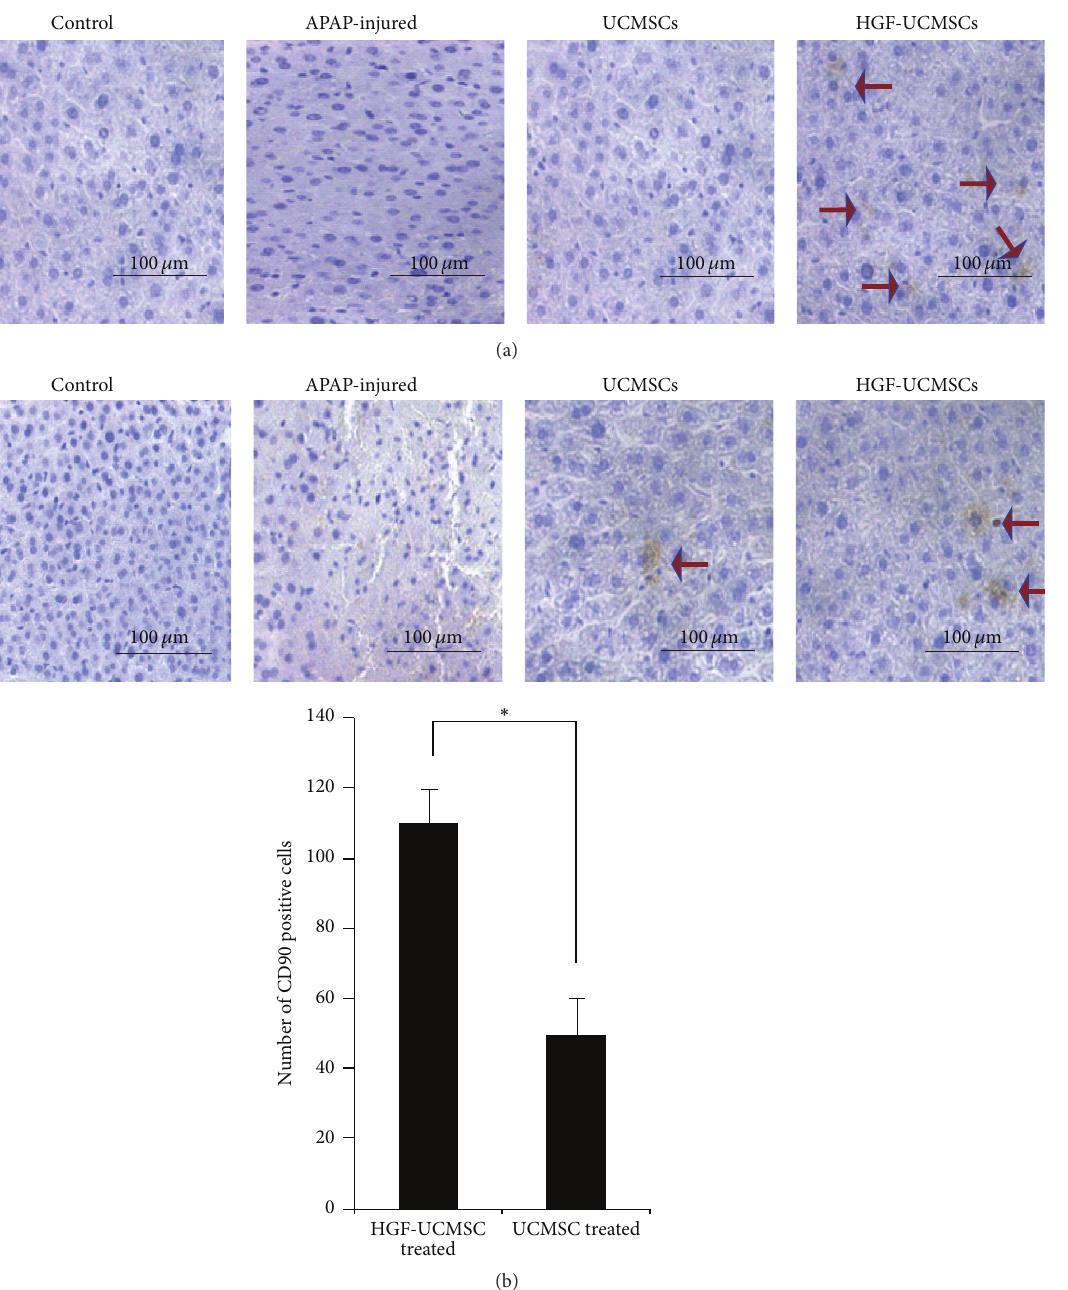
Figure 4: Migration of HGF-UCMSCs into the injured area of the liver. Migrated MSCs in the liver were detected by immunohistochemical staining of HGF (a) and mesenchymal marker CD90